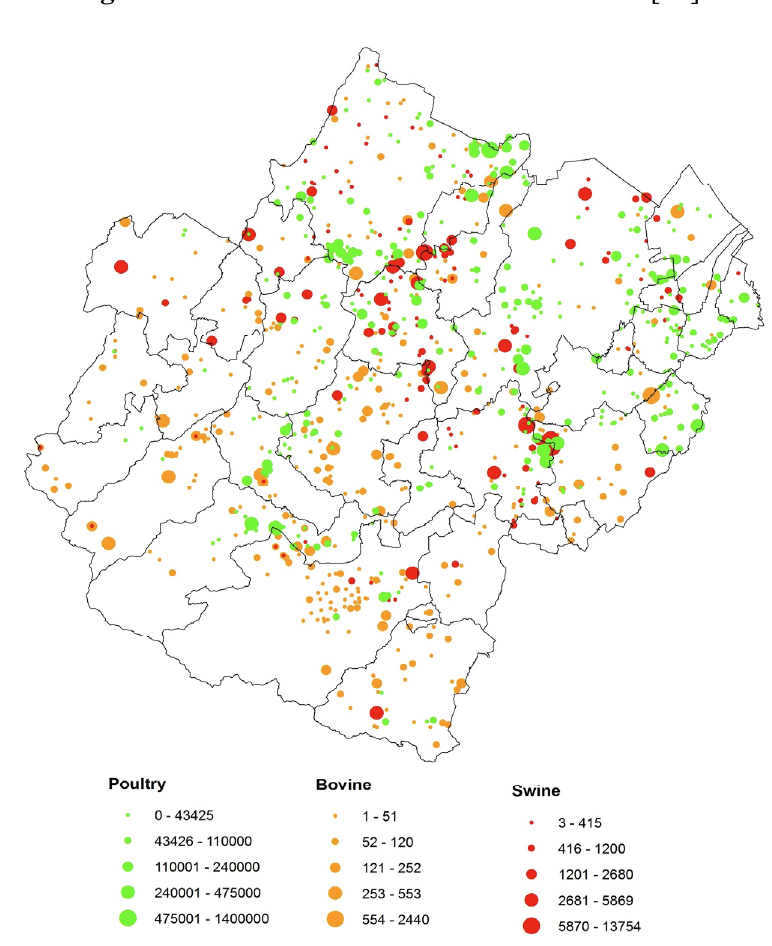
Figure 2. Distribution and size of animal farms